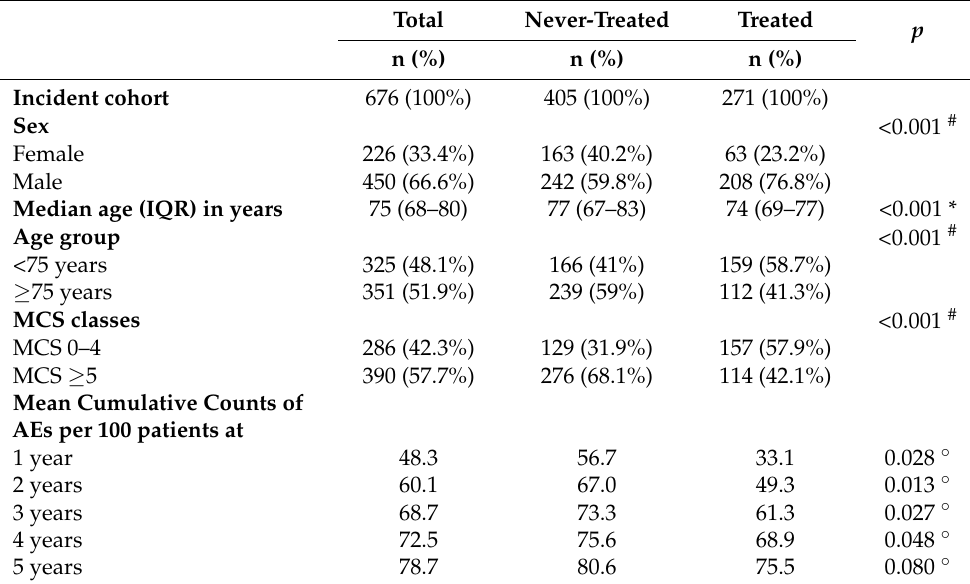
Table 1. Subjects’ characteristics at IPF diagnosis according to